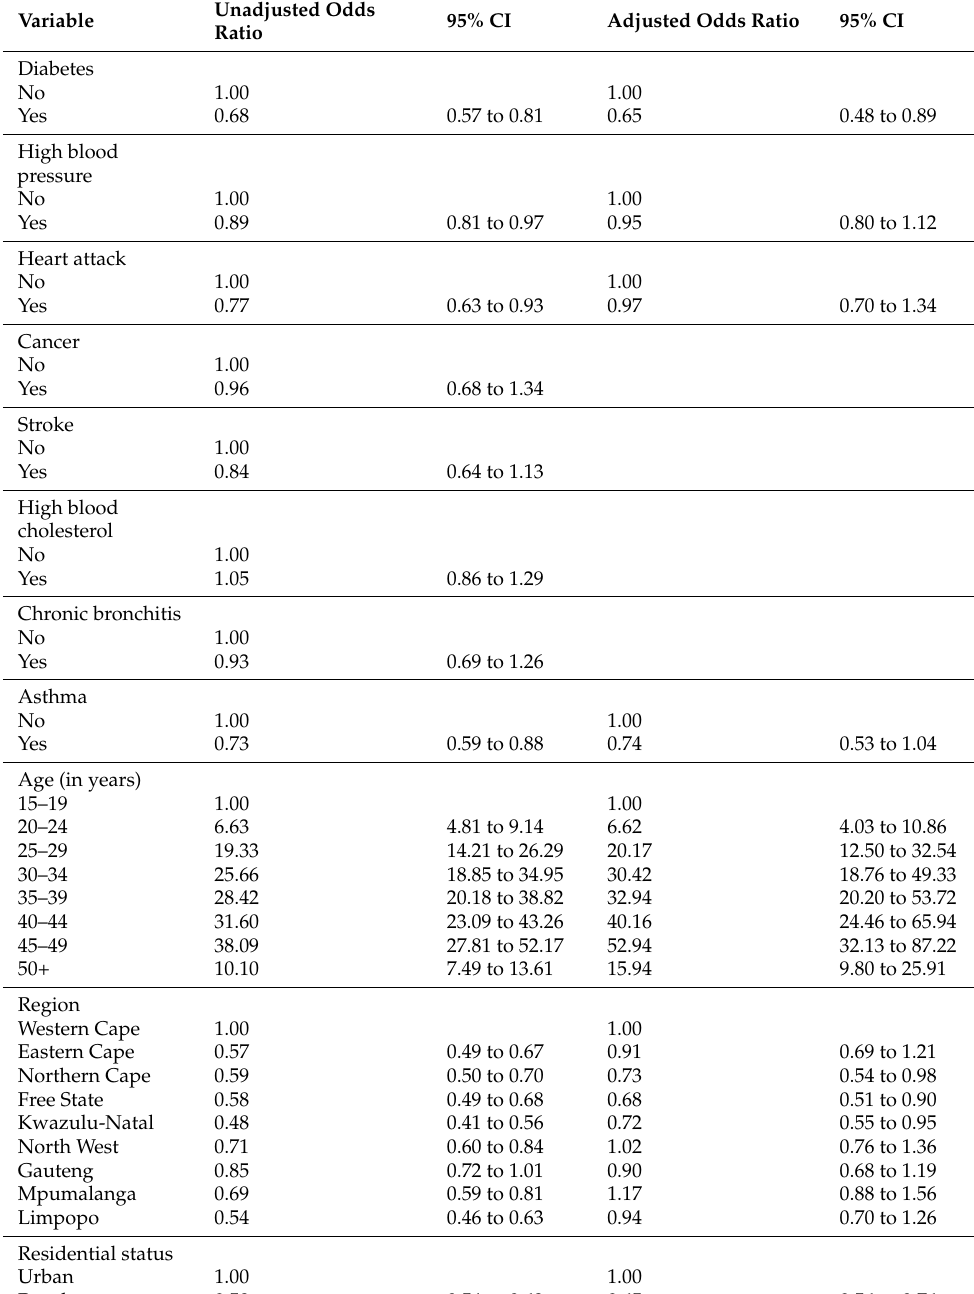
Table 3. Diabetes and covariates associated with labour force participation among